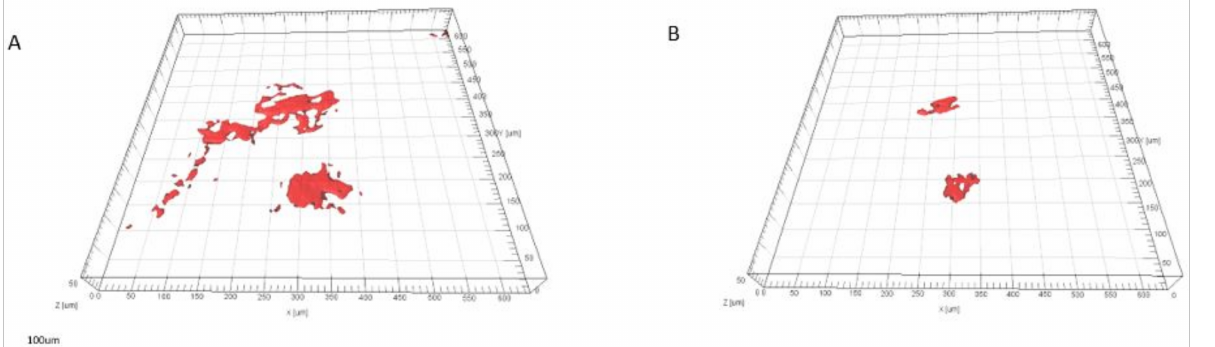
Figure 11. IMARIS 3-D images showing biofilms on PVA covered with Li-ZnO. ( A ) PVA with ZnO and ( B ) 0.3 wt% Li-ZnO-impregnated PVA. Dead cells can be seen as red clumps. Every image is a perspective that measures several 600 m by 600